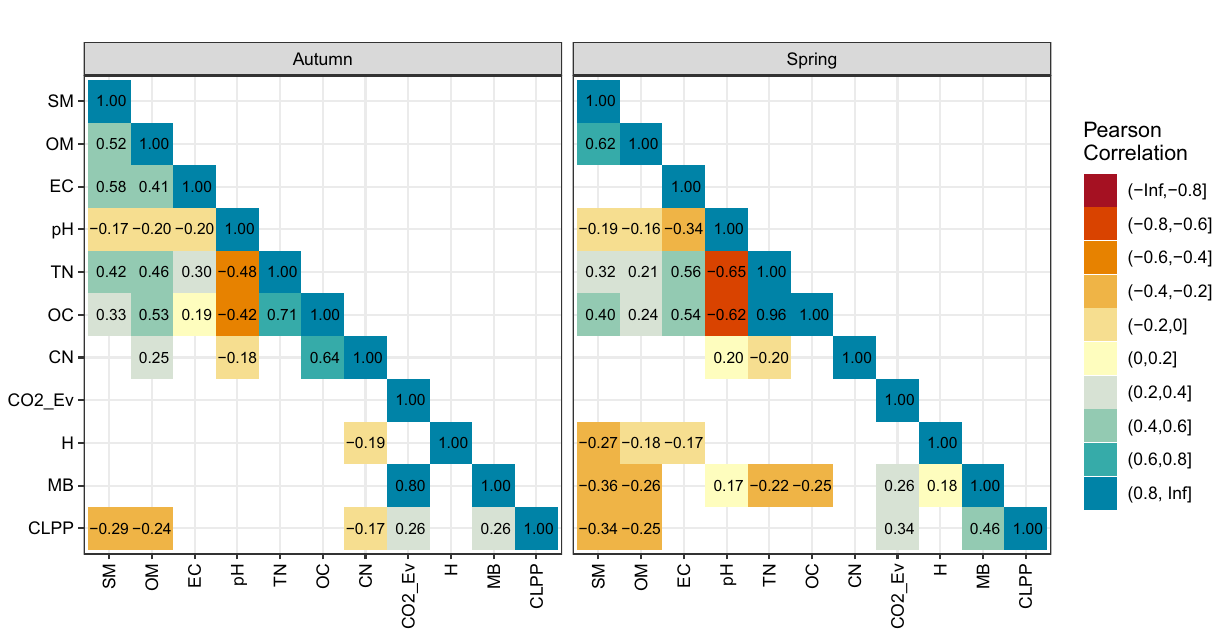
Figure 3. Pairwise correlation between soil characteristics, in each of two seasons. Text labels specify the Pearson correlation coefficient. Insignificant ( p > 0.05) correlation coefficients are not